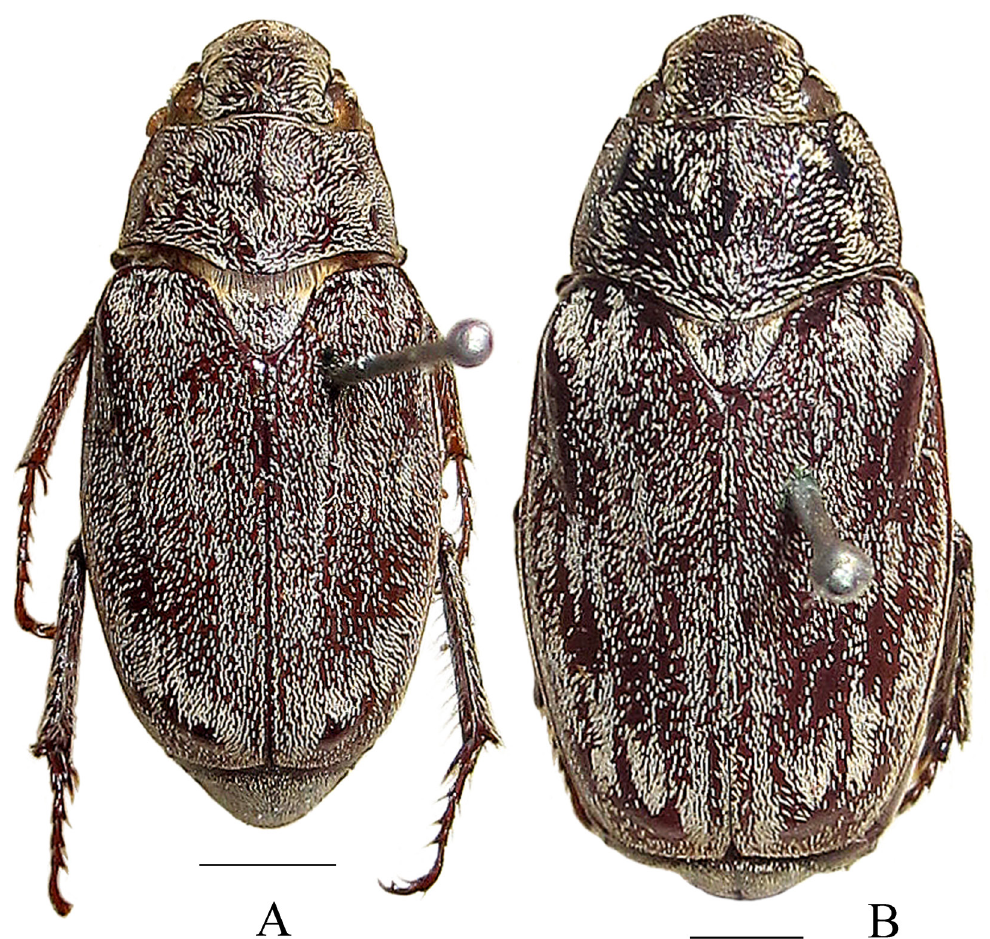
Fig. 3. Philacelota leucothea sp. nov., habitus. A . ♂, holotype (MNHN). B . ♀, paratype (MNHN). Scale bars: 2.5